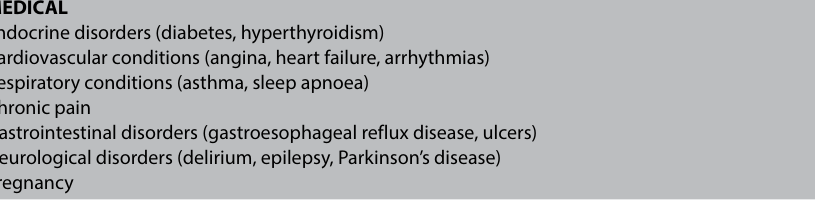
Neurological disorders (delirium, epilepsy, Parkinson’s disease)